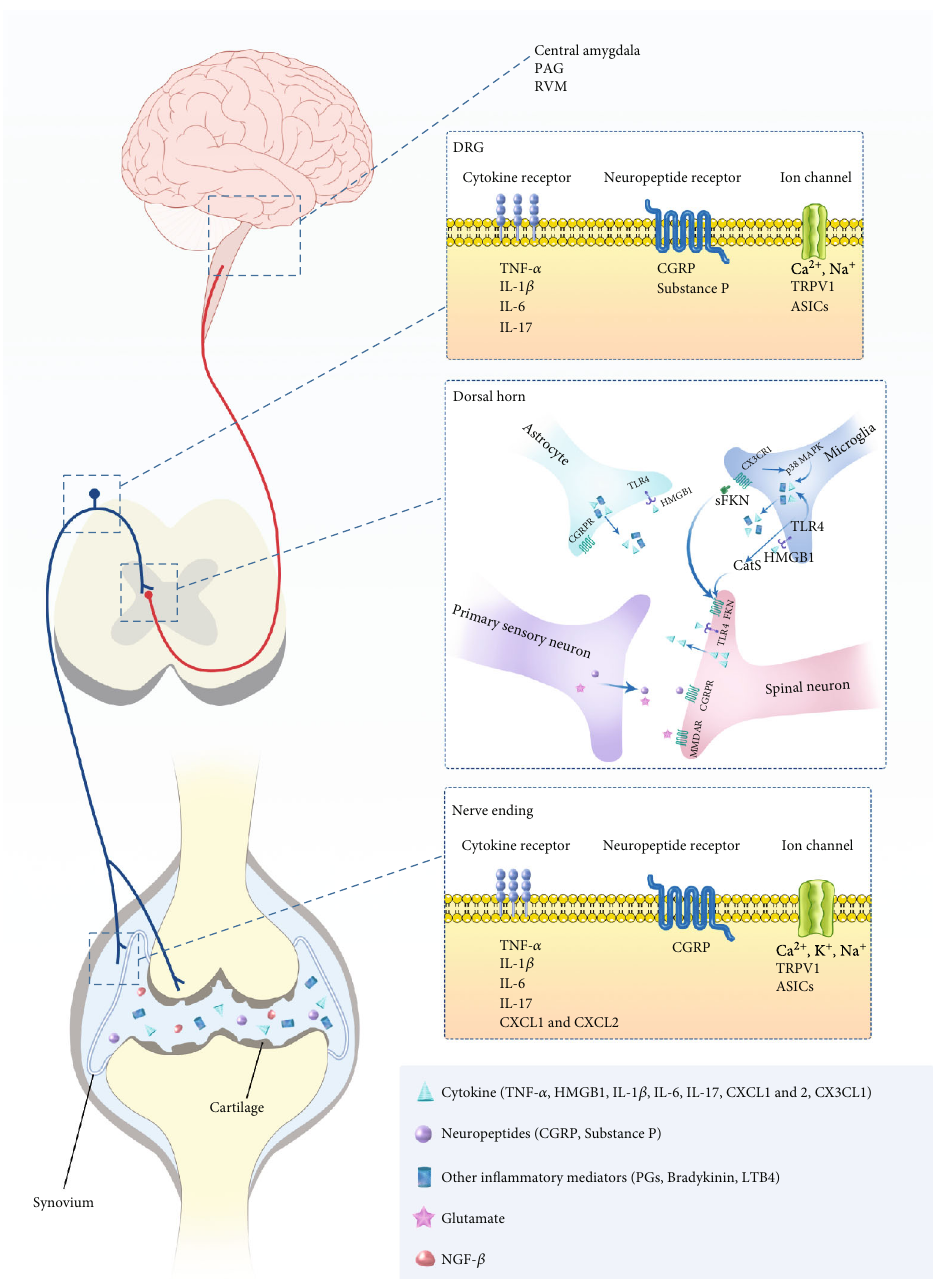
Figure 1: Schematic overview of reported peripheral and central mechanisms of RA pain. Most of the structures in the joint are dominated by nociceptive neurons whose cell bodies are located in the DRG. During joint in fl ammation, the resident cells and in fi ltrating immune cells in the joint release proin fl ammatory cytokines (e.g., TNF- α , IL-1 β , IL-6, and IL-17) and the sensory nerve endings release CGRP, which activate and/or sensitize the primary a ff erents. The activation of primary a ff erents results in the change of DRG gene expression. Glutamate and neuropeptides (e.g., CGRP) are released from central nerve endings and peripheral sensory nerve endings, and their receptors are activated, respectively. Activated astrocytes and microglia release proin fl ammatory cytokines (e.g., TNF- α ) in the spinal cord, which will contribute to the spinal sensitization. Microglia also release CatS, cutting FKN on spinal cord neurons, and the resulting soluble FKN (sFKN) further enhances the reactivity of microglia via CX3CR1. HMGB1 is released from spinal neurons and activates TLR4 on glial cells and spinal neurons. The increase of CGRP in the dorsal horn regulates the secondary a ff erent activity. CGRP is widely expressed in the central nervous system (CNS) and plays a role in the amygdala, pons, and other brain stem areas to enhance the nociceptive signal. DRG: dorsal root ganglion; TNF- α : tumor necrosis factor- α ; IL-1 β : interleukin-1 β ; IL-6: interleukin-6; IL-17: interleukin-17; CGRP: calcitonin gene-related peptide; CatS: cathepsin S; FKN: fractalkine; HMGB1: high-mobility group box 1 protein; TLR4: toll-like receptors; NGF- β : nerve growth factor- β